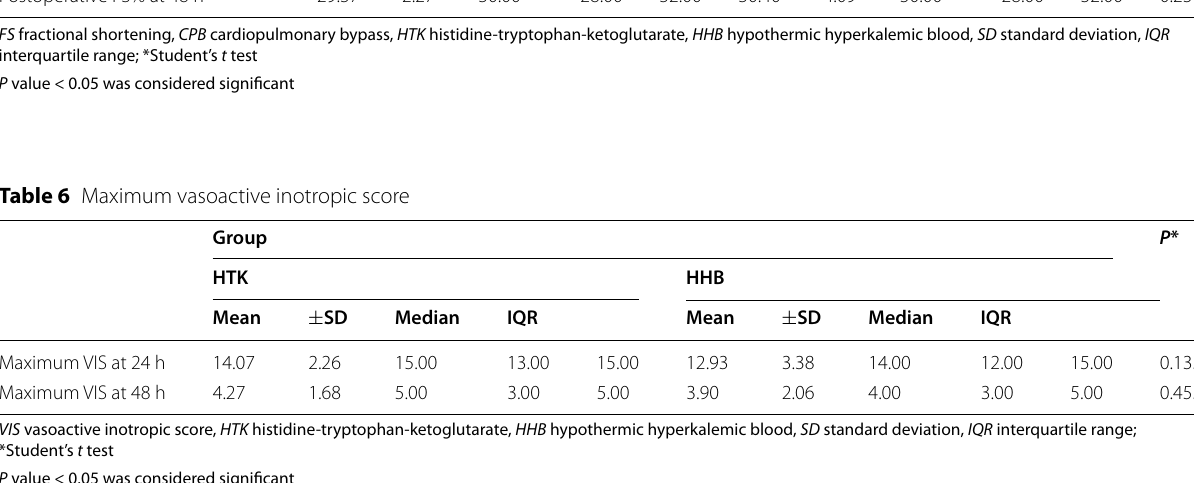
FS fractional shortening, CPB cardiopulmonary bypass, HTK histidine-tryptophan-ketoglutarate, HHB hypothermic hyperkalemic blood, SD standard deviation, IQR interquartile range; *Student’s t test